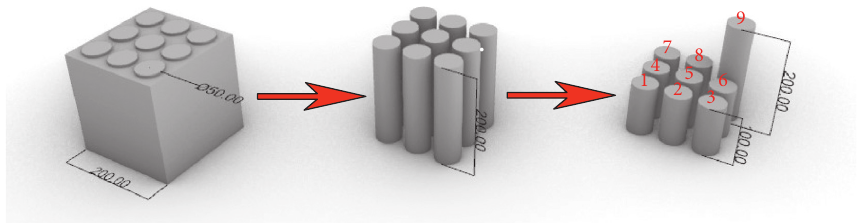
Figure 1: Schematic diagram for making backfill specimen.